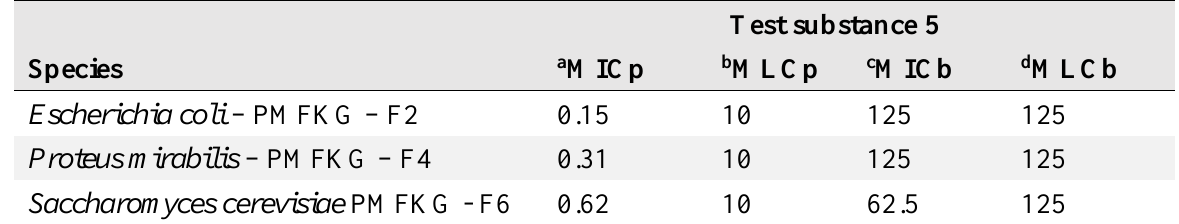
Table 8. Resistance of planktonic cells and biofilms in the presence of test substance